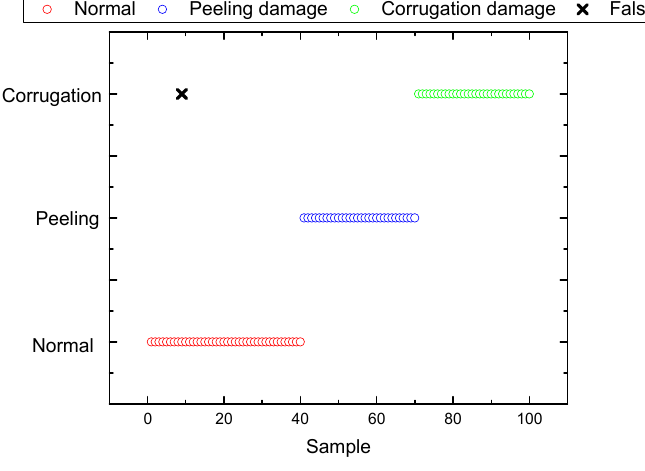
Figure 17. Identification accuracy of the proposed method.